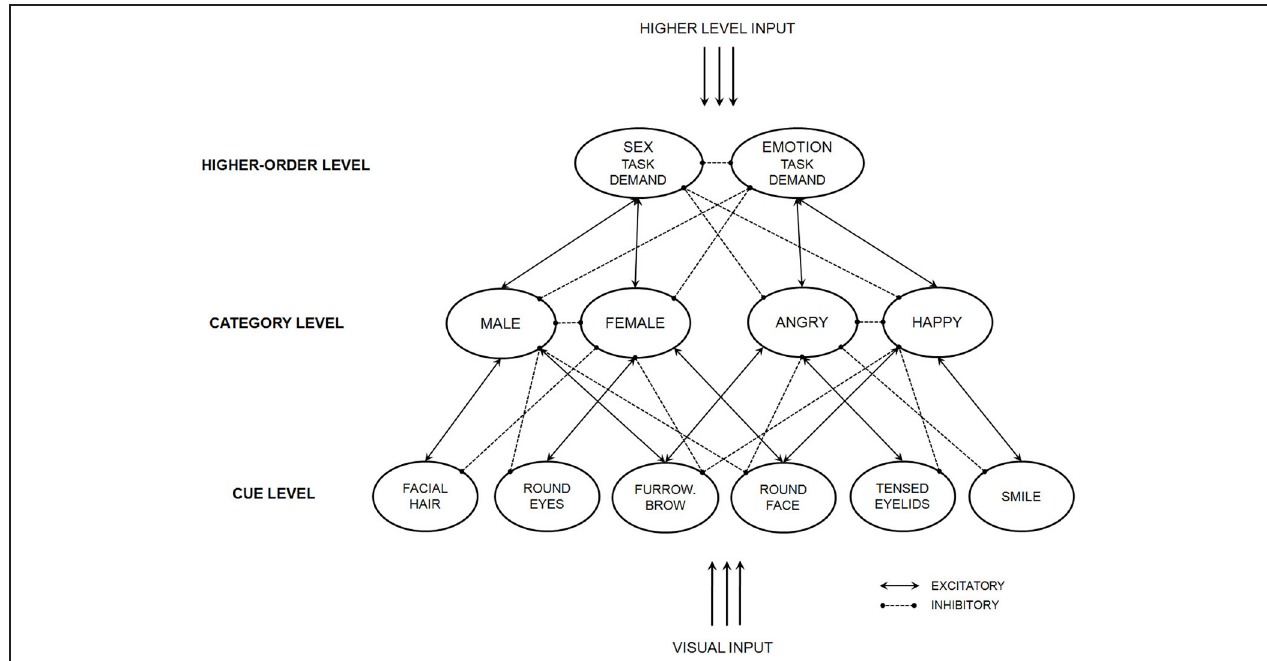
FIGURE 3 | An instantiation of the dynamic interactive model that gives rise to category interactions driven by bottom-up perceptual cues. Adapted from Freeman and Ambady